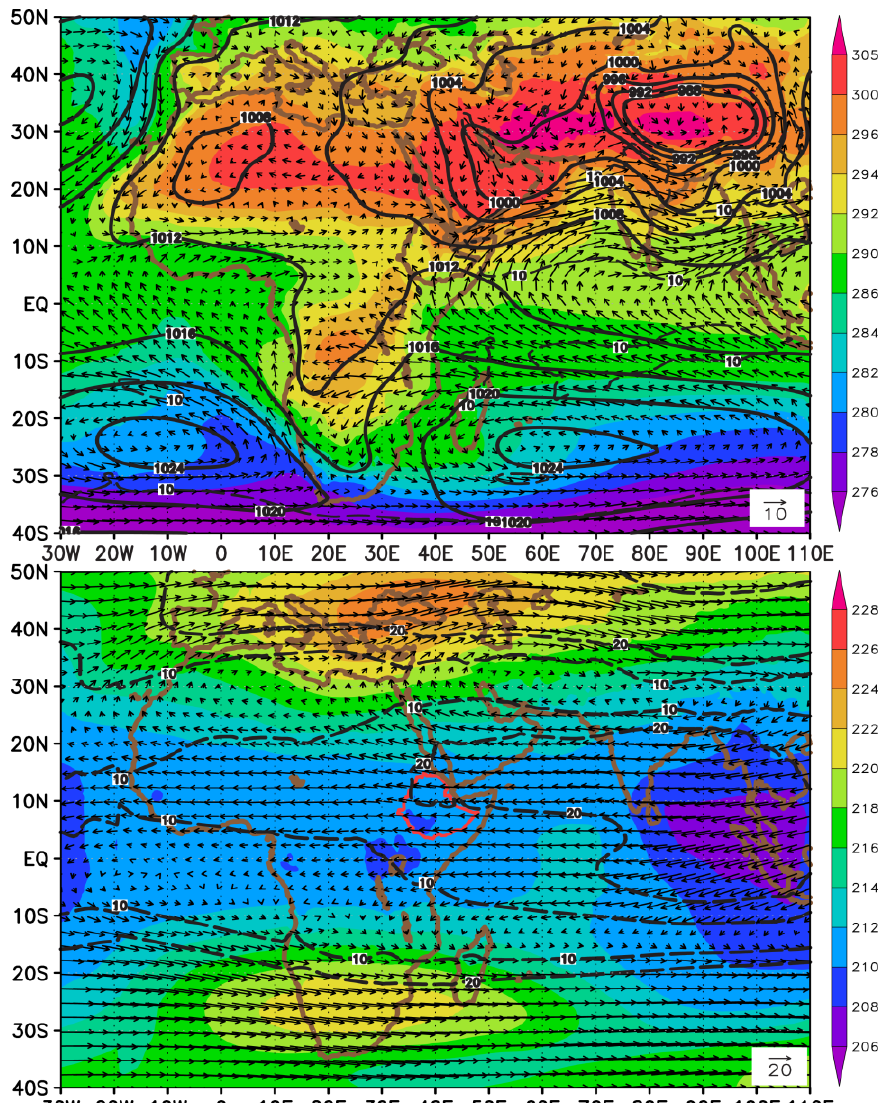
Figure 4. July–August wind (vector), resultant wind speed (dashed contour), and temperature (shading; K, color scale at right) patterns for CNTRL simulation for 850 hPa ( top ) and 150 hPa ( bottom ). Mean sea level pressure (hPa) is shown in top panel. Arrows give wind vectors (m·s −1 , magnitude scale in lower right corner) and magnitude is also contoured (5 m·s −1 intervals). The border of Ethiopia is delineated by a solid bright red